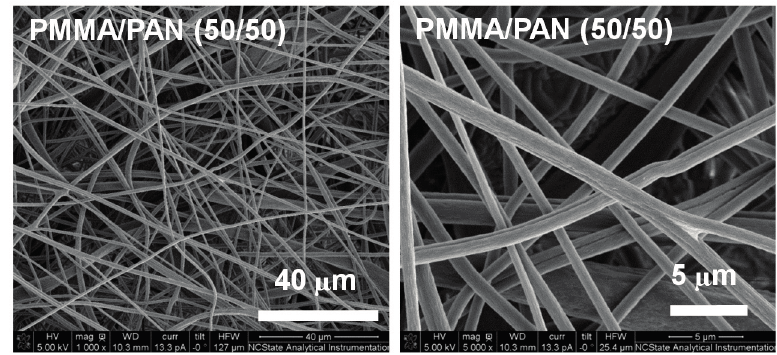
Figure 2. SEM images of PMMA, PMMA/PAN (75/25), and PMMA/PAN (50/50) membranes.